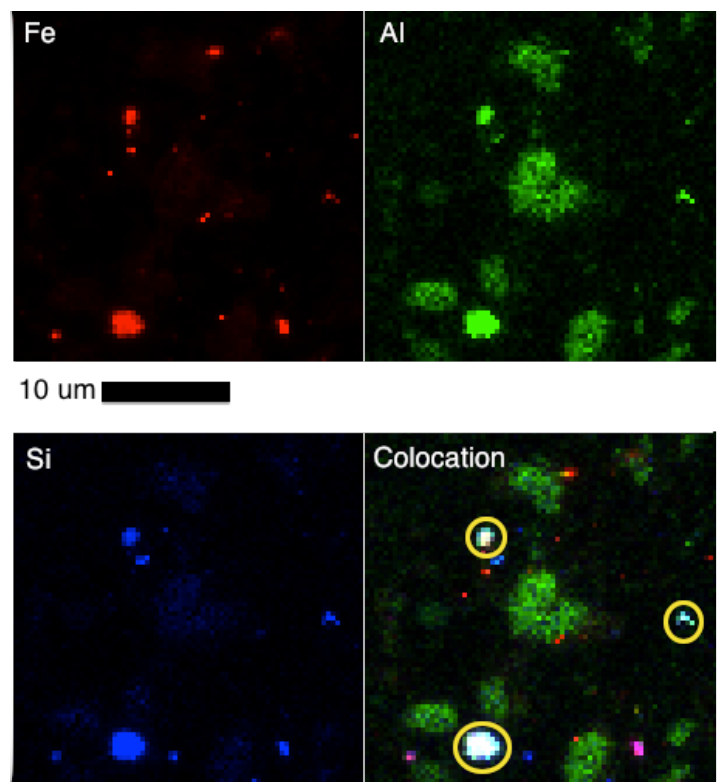
Fig. 1. Elemental maps (30 × 30µm) of iron (red), aluminum (green), and silicon (blue) from South Dekalb 11/11/08 filter sample are presented. The fourth map is a colocation map, where the iron map is superimposed on aluminum and silicon maps. The white particles on the colocation plot indicate that iron, aluminum and silicon are concentrated in this area. The yellow circles on the colocation plot indicate 3 iron-containing particles that are enriched in aluminum and